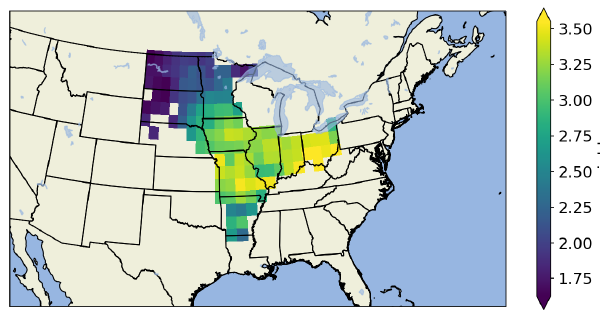
Figure 2. Selected grid points for the main producer states and the mean yields (t/ha) per grid cell as simulated by the EPIC-IIASA